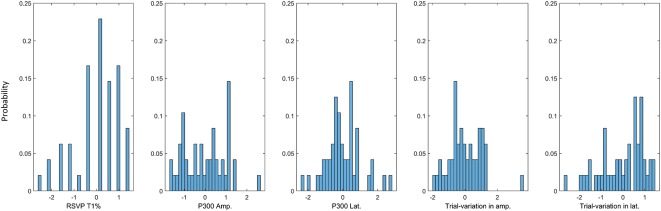
Data distribution of each RSVP feature. The distribution of each of the RSVP features is depicted using relative frequency histograms (N = 48). Compared to the other RSVP features, RSVP T1% showed a sharp and sparse distribution.